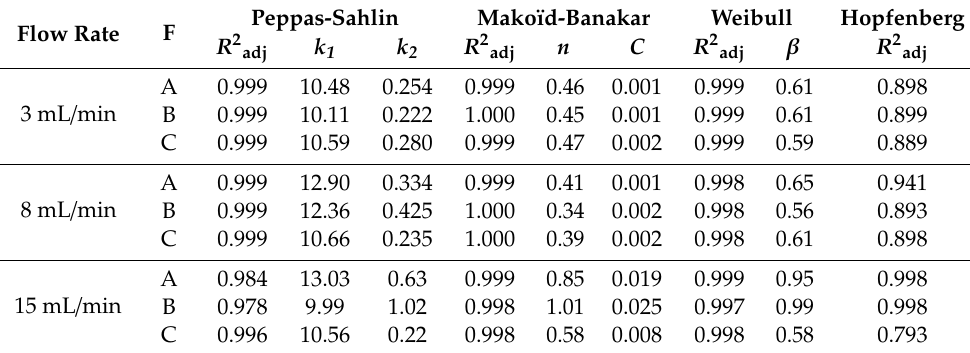
Table 5. Goodness of fit and relevant parameters values of applied mathematical